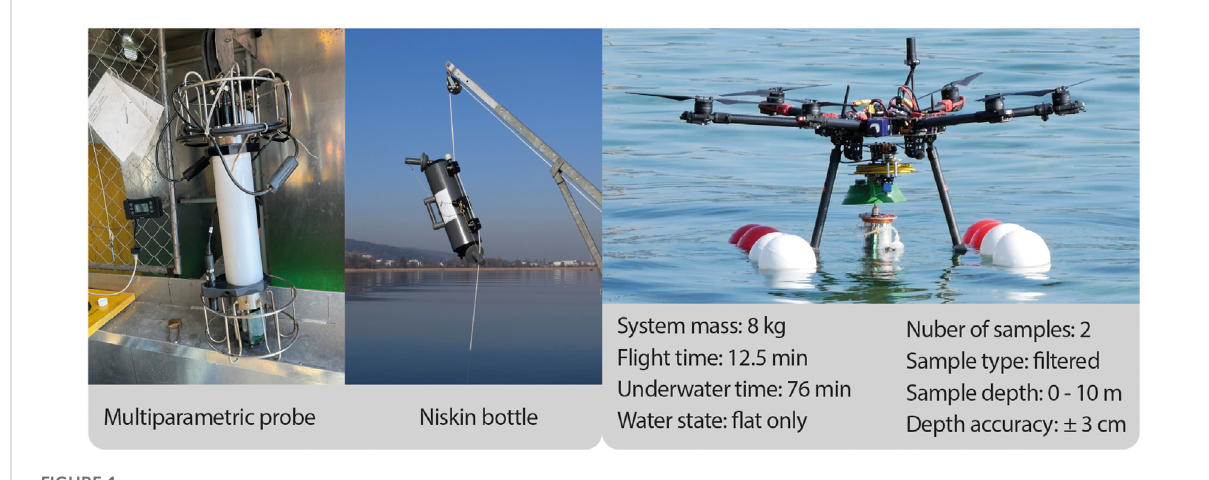
FIGURE 1 Sampling methods used in this publication. A multiparametric probe collects data autonomously along a vertical pro fi le of the lake in a fi xed location. A Niskin bottle is used off-board a motor-boat to collect water at depth for later fi ltration and analysis. The MEDUSA system developed for remote acquisition of water samples at